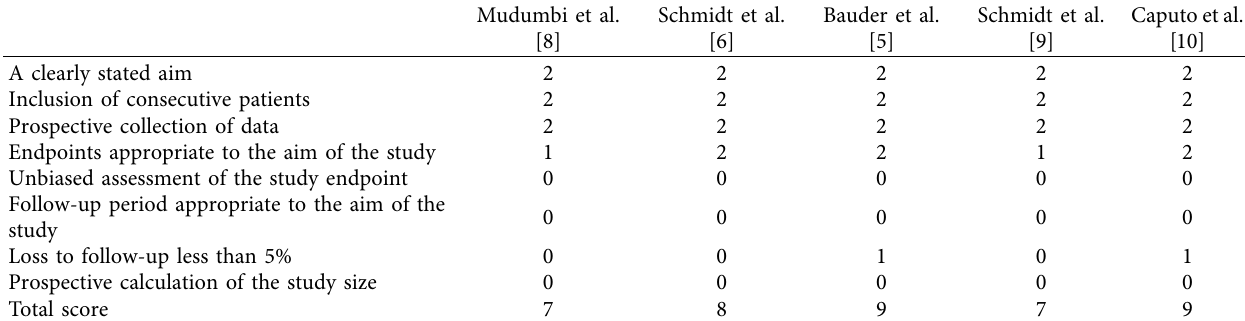
Table 1: Assessment of study quality using methodological index for nonrandomized studies (MINORS).